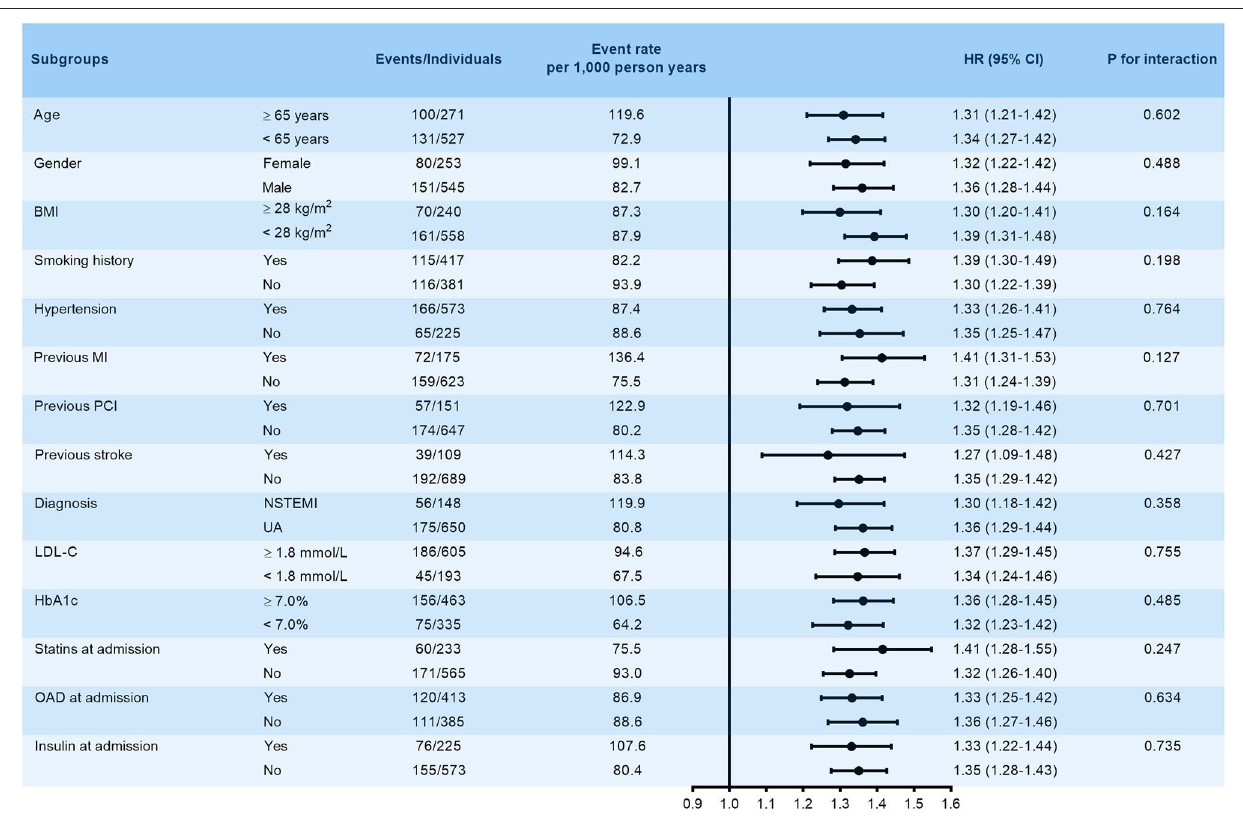
FIGURE 3 | Subgroup analysis evaluating the robustness of VAI in predicting the risk of the primary endpoint. The analysis was adjusted for model 5 except for variates applied for grouping. HR was evaluated by per 1-unit increase of VAI. BMI, body mass index; MI, myocardial infarction; PCI, percutaneous coronary intervention; NSTEMI, non-ST-segment elevation myocardial infarction; UA, unstable angina; LDL-C, low-density lipoprotein cholesterol; HbA1c, glycosylated hemoglobin A1c; HR, hazard ratio.